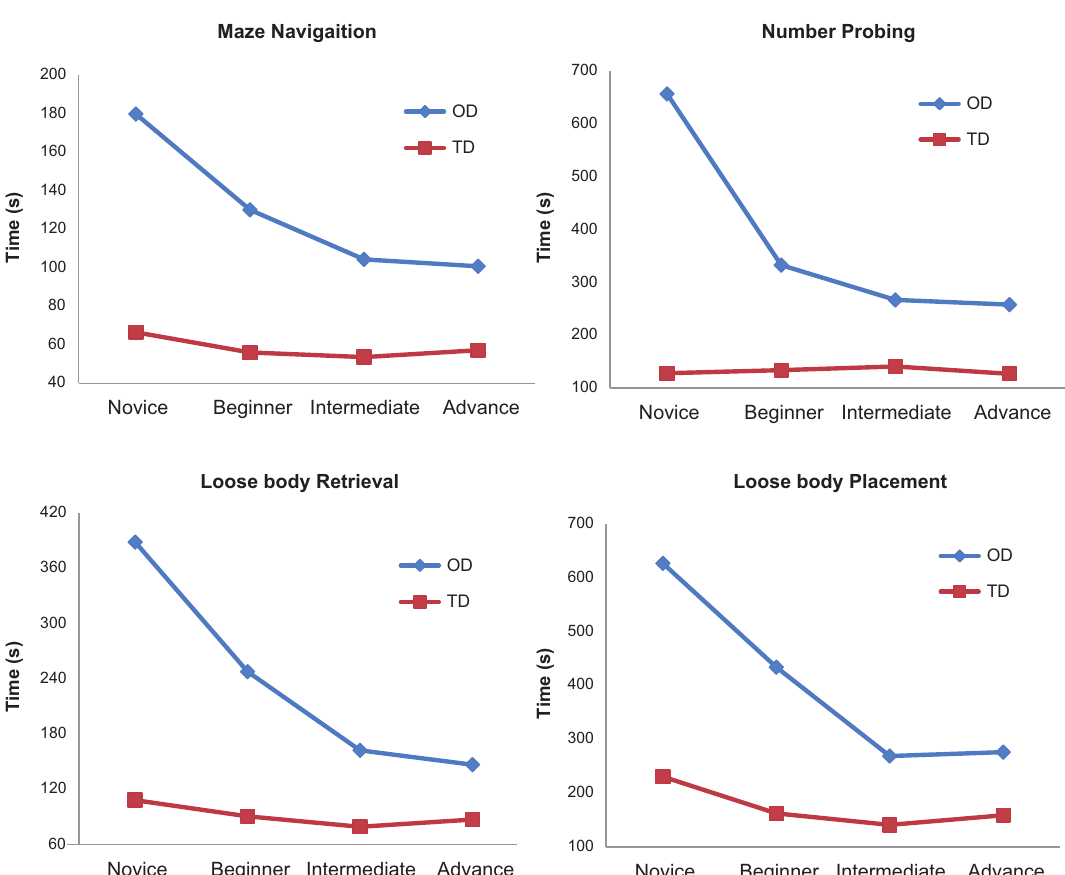
Figure 3. Graphical representation of mean time taken by groups to complete tasks under transparent dome (TD) and opaque dome (OD).